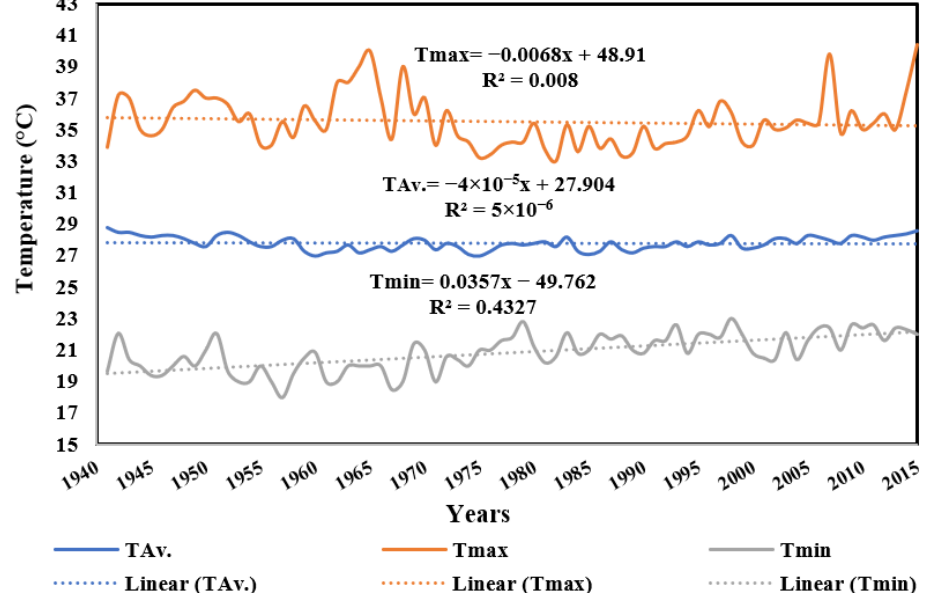
Figure 3. Representation of the time series of the maximum, mean and minimum temperatures recorded at the Rafael Núñez Airport station.